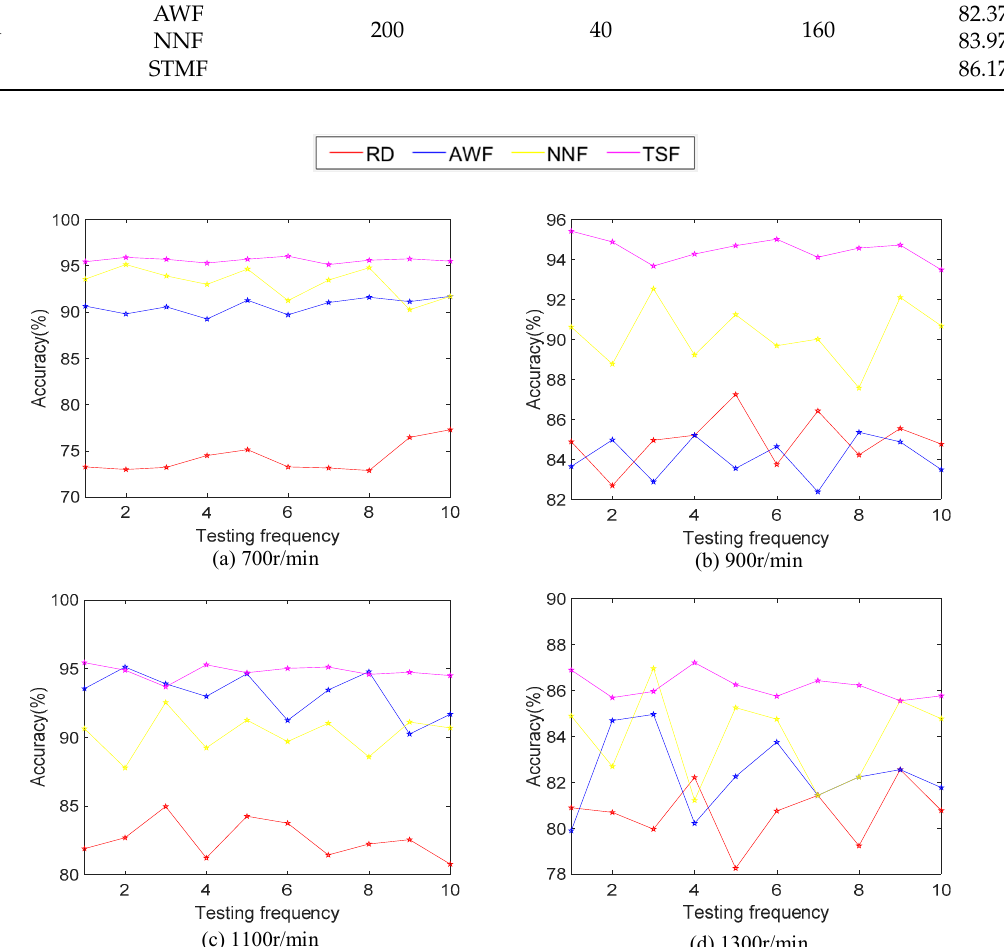
Figure 14. Accuracy difference diagram under different speed conditions. Table 4. SAE handles the fault classification accuracy rate of different data.